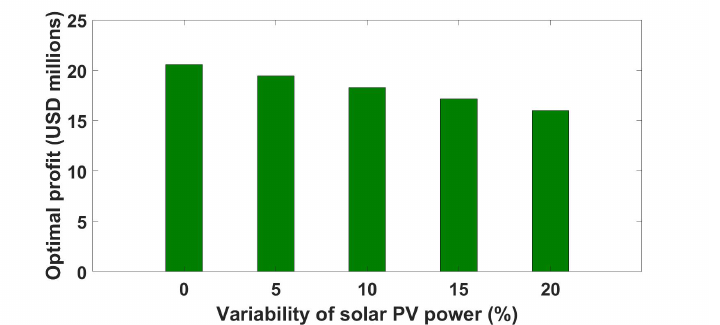
Figure 10. Influence of the variability of solar PV power on the optimal